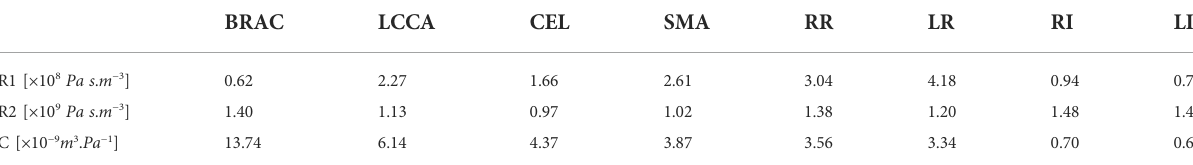
TABLE 3 3-Element Windkessel parameters for all branches. Branches include brachiocephalic (BRAC) and left common carotid (LCCA) artery, celiac trunk (CEL), superior mesentric artery (SMA), right (RR) and left (LR) renal, and right (RI) and left (LI) iliac. Reported parameters are proximal resistance (R1), distal resistance (R2) and compliance (C).